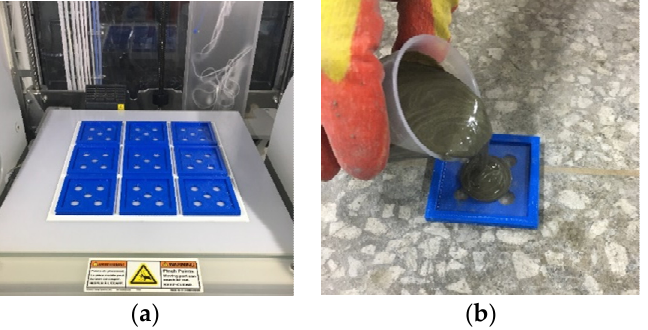
Figure 7. Fabrication of specimen for observation of crack: ( a ) mold for disc specimens for crack observation, ( b ) disc specimen fabrication process.